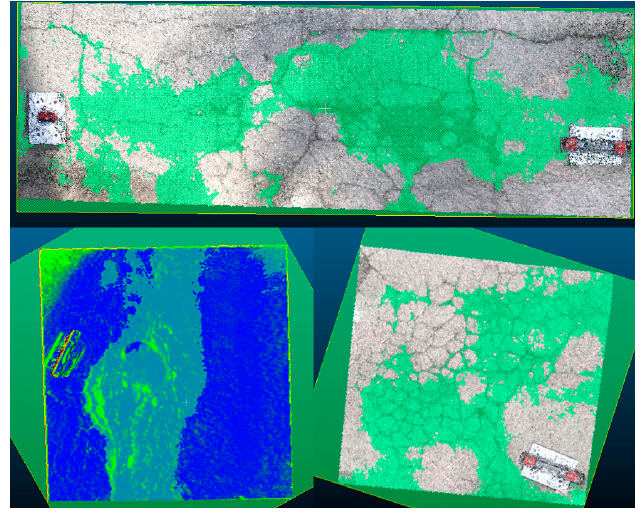
Figure 28. Application of 'fit' plane to each pavement section.